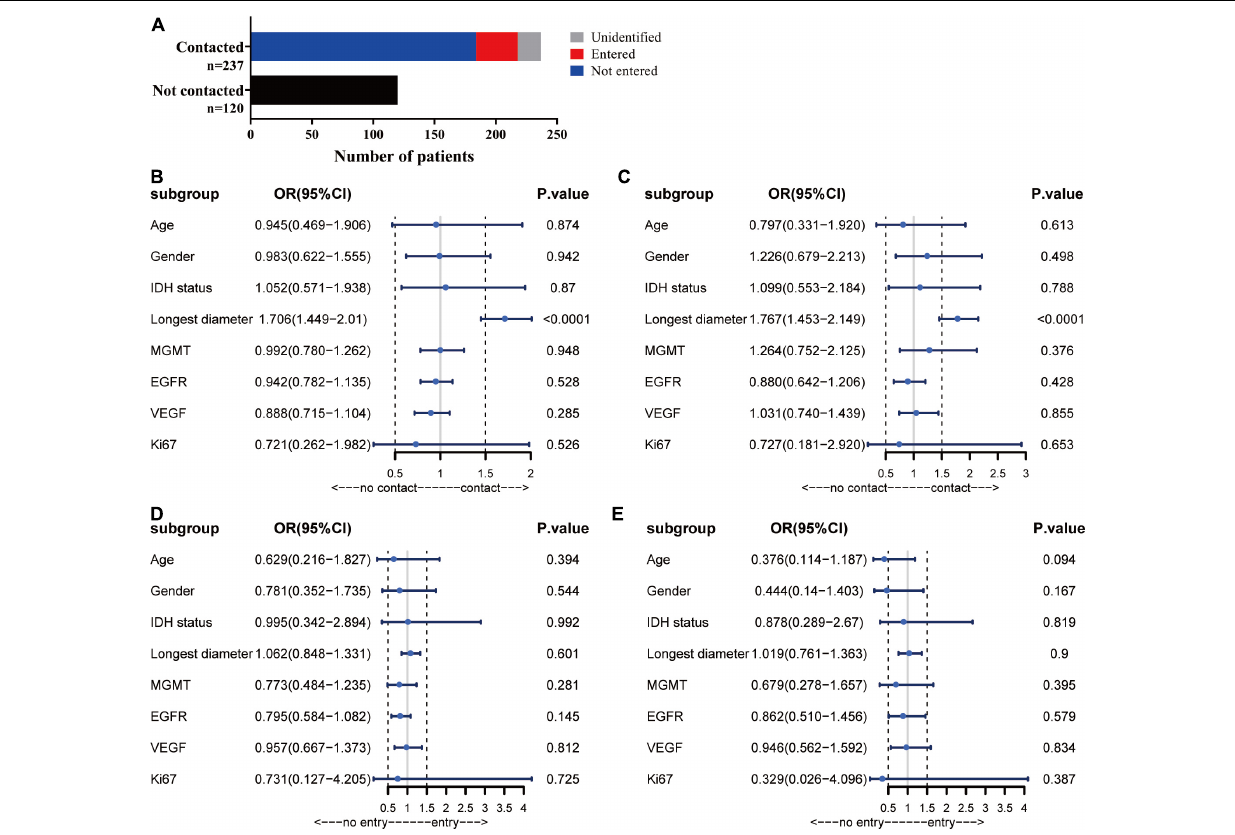
FIGURE 2 | Analysis of MRI results. (A) Statistics for the relationship between tumor location and ependymal region. (B) Forest plot showing that a high longest tumor diameter was a risk factor for ependymal region contact, whereas there was no correlation with patient age, sex, IDH status, MGMT, EGFR, VEGF or Ki67. (C) The results showed that the ventricular entry risk was not correlated with age, sex, longest tumor diameter, IDH status, MGMT, EGFR, VEGF or Ki67. (D) All the characteristics have no correlation with the lateral ventricle penetration of GBM in the univariate binary logistics analyses. (E) All the characteristics have no correlation with the lateral ventricle penetration of GBM in the multivariate binary logistics